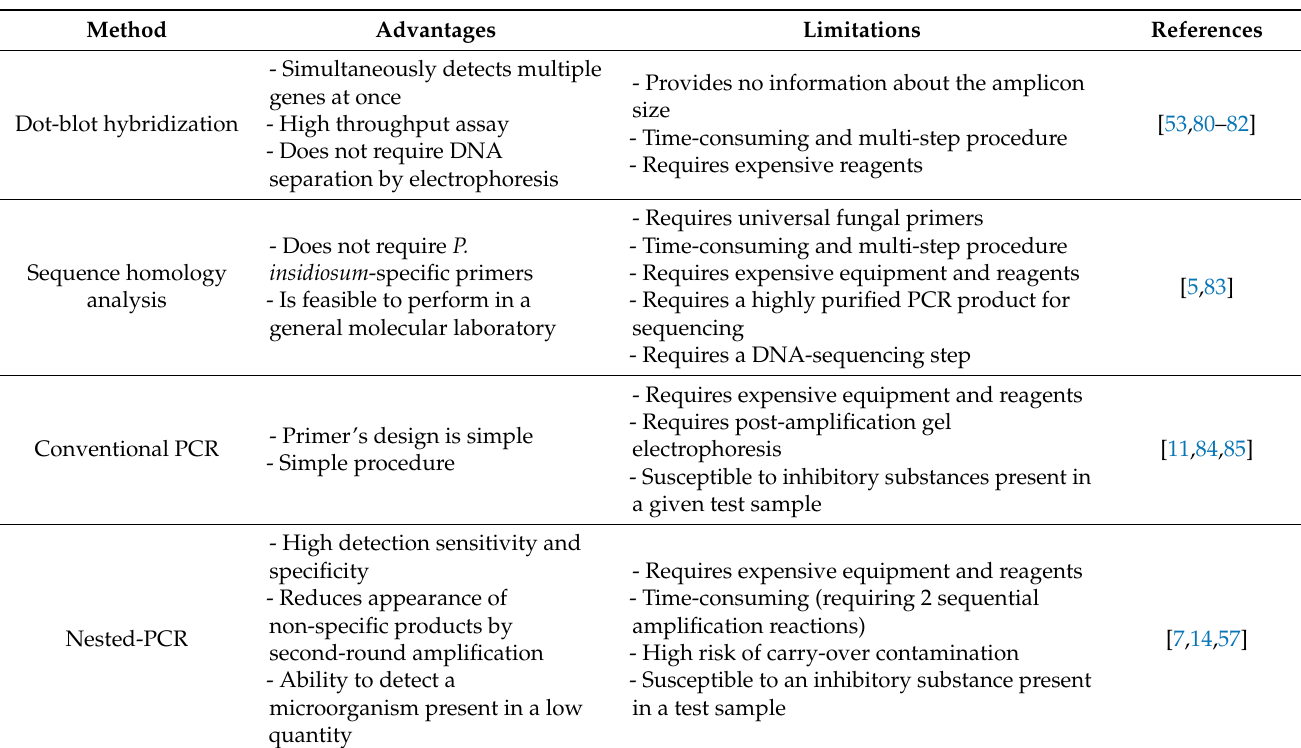
Table 2. Advantages and limitations of each nucleic acid-base test for P. insidiosum detection. Method